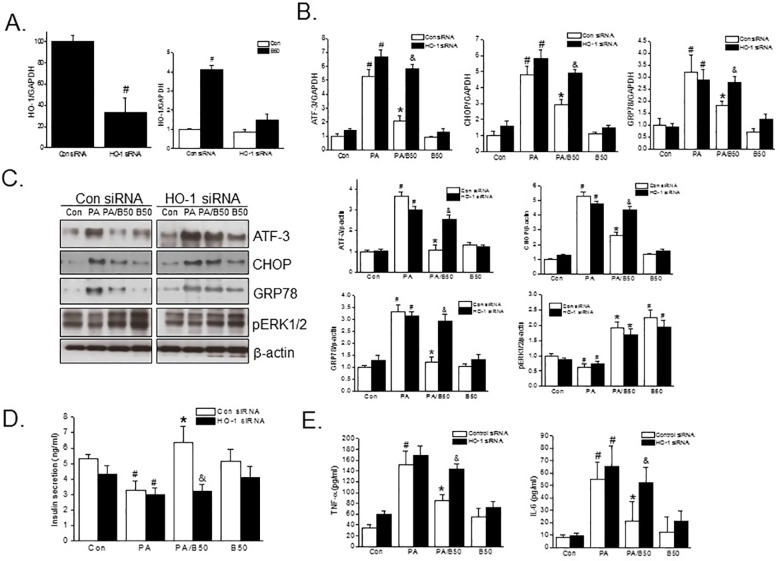
Attenuation of the protective effects of baicalein by HO-1 knockdown.INS-1 cells were transfected with 20 nM HO-1 siRNA or control siRNA for 36 h, and the reduction of HO-1 mRNA expression was determined (A left). HO-1 siRNA or control siRNA transfected cells were treated with baicalein (50 μM) for 3 h, and then HO-1 mRNA expression was determined by qPCR (A right). After HO-1siRNA transfection, cells were treated with baicalein (50 μM) for 3 h and PA was then added and incubation continued for 8 h (for qPCR) or 24 h (for western blot or ELISA). The expression levels of ER stress makers (B) were assessed by qPCR. Protein levels of ER stress markers and phosphorylated ERKs were determined by Western blotting (C). Insulin secretion (D) and secreted TNF-α and IL-6 (E) levels were assessed by ELISA. The results shown are representative of three independent experiments and are expressed as means ± SDs. #P<0.05 vs. controls; *P<0.05 vs PA alone; &P<0.05 vs. PA plus baicalein with control siRNA transfection.